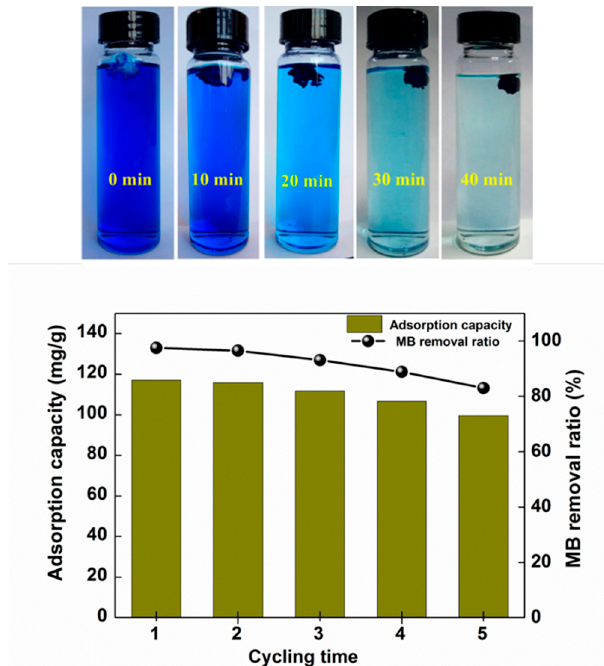
Figure 9. Adsorption and regeneration performance of CNC-g-AA-2-120-8 aerogels for MB.